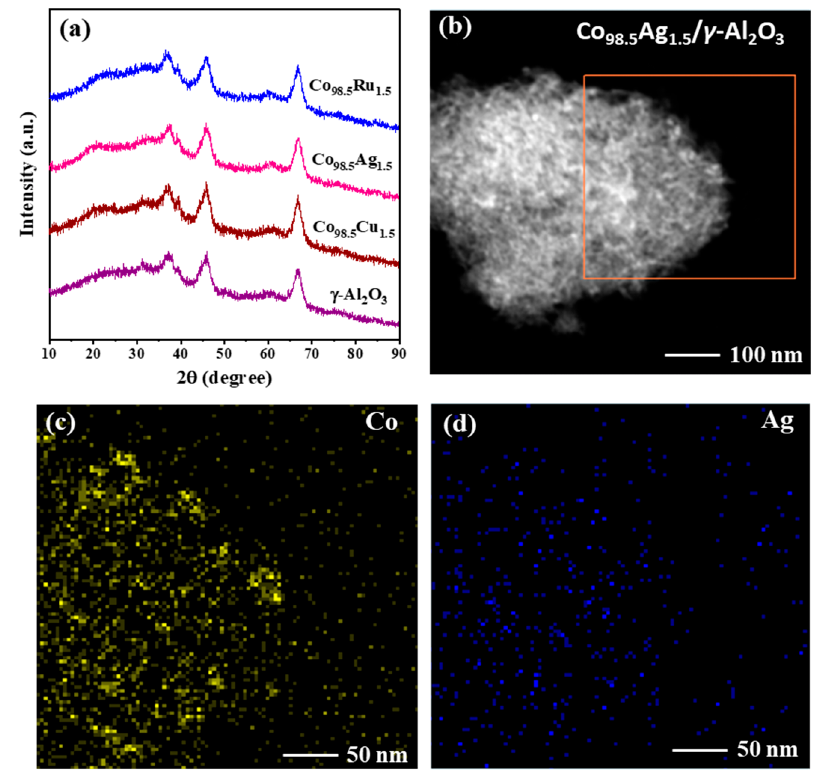
Figure 3. ( a ) Powder X-ray diffraction patterns for Co 98.5 M 1.5 / γ -Al 2 O 3 (M = Cu, Ag, Ru; 5 wt% Co) samples with the γ -Al 2 O 3 support as reference; ( b ) scanning transmission electron microscopy images for Co 98.5 Ag 1.5 / γ -Al 2 O 3 with inserted EDS mapping of ( c ) Co and ( d ) Ag elements for the selected region.